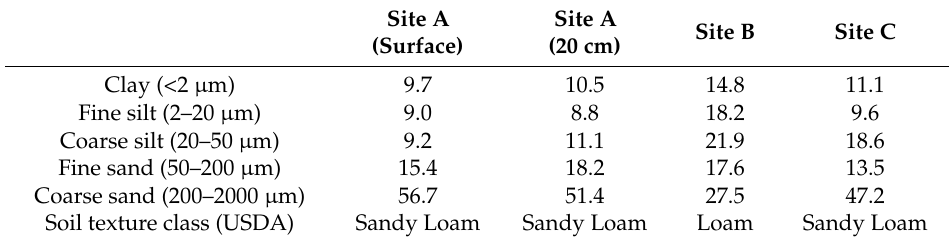
Figure 1. Study sites: ( a ) Site A; ( b ) Site B; ( c ) Site C. Table 1. Particle size distribution and soil texture class of each site (results are given in % w / w ).